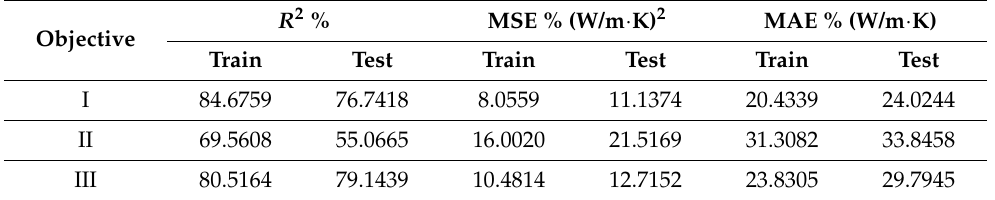
Table 6. GEP model error calculation of each network.